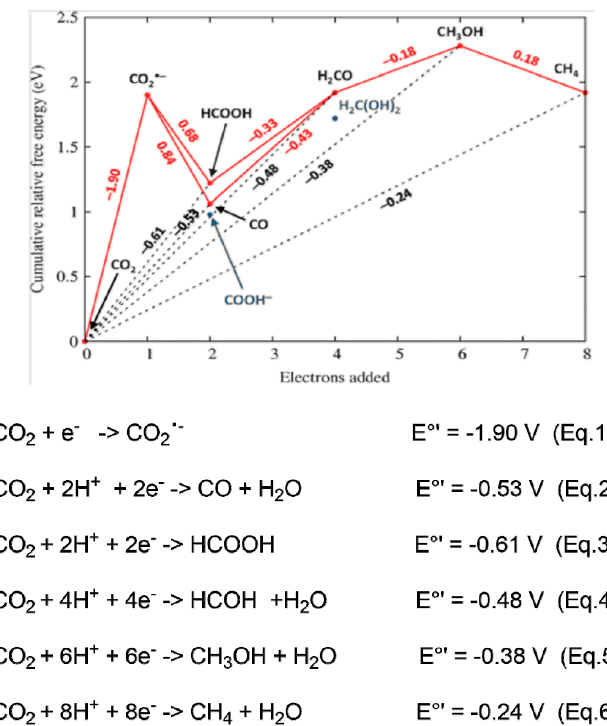
Figure 1. Latimer ‐ Frost diagram for the multi ‐ electron, multi ‐ proton reduction of CO 2 in homogeneous aqueous solution (redox potential are reported vs. NHE, under standard conditions at pH = 7, 25 °C, 0.1 MPa of gases and 1 M solutes). Reprinted with permission from [157]. 2012 Copyright, Royal Society of Chemistry, UK.